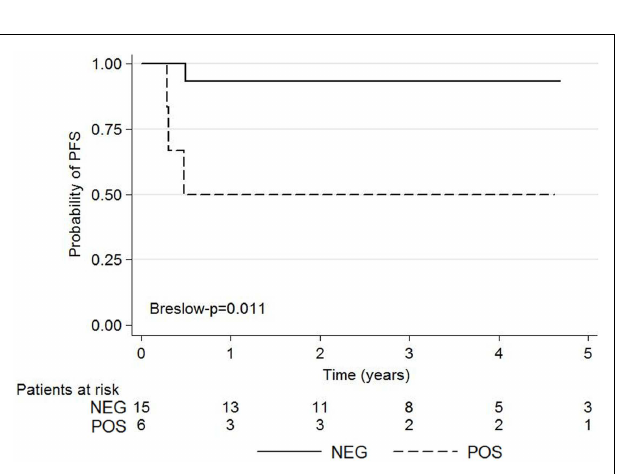
FIGURE 3 | Kaplan–Meier survival graphs show 5-year PFS according to negative and positive post-induction chemotherapy 18 FDG-PET using the Deauville criteria .